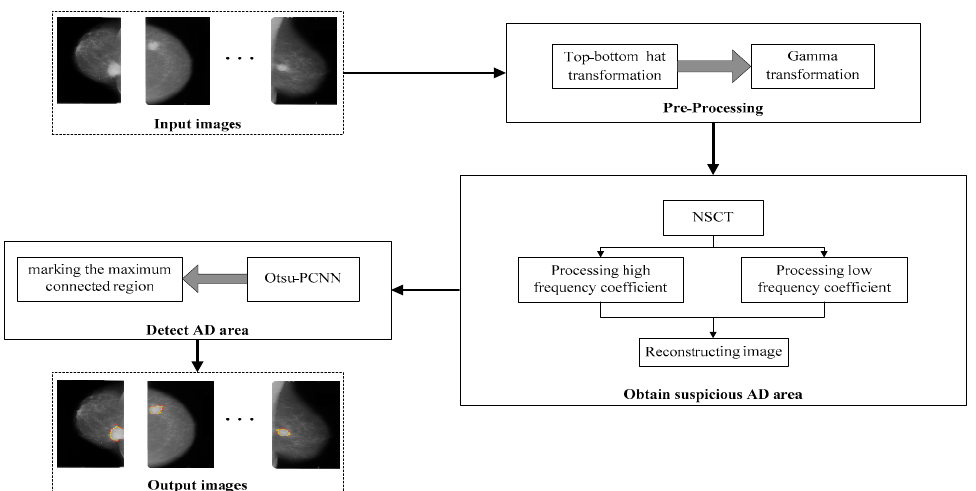
Figure 1. The flow chart of the proposed algorithm. NCST: non-subsampled contourlet transform; AD: architectural distortion; PCNN: pulse coupled neural network. This paper selects the “B_3412_1.LEFT_CC” mammogram in the DDSM database for a comprehensive description of the proposed detection